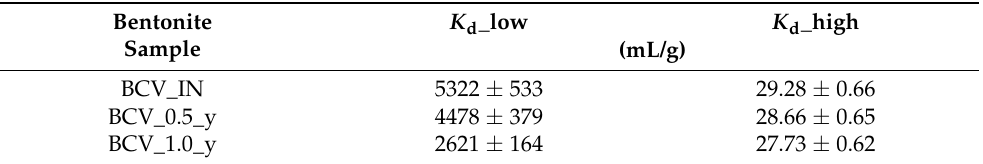
Table 3. Caesium distribution coefficients K d at two different carrier concentrations (low~0.0008 mmol/L Cs, high~62 mmol/L Cs).